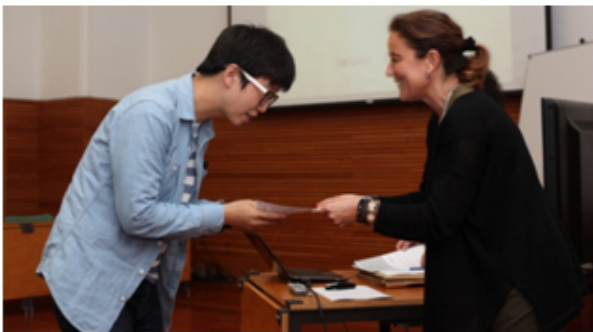
Figure 6. E4SD: Vice-President handing participation certificates